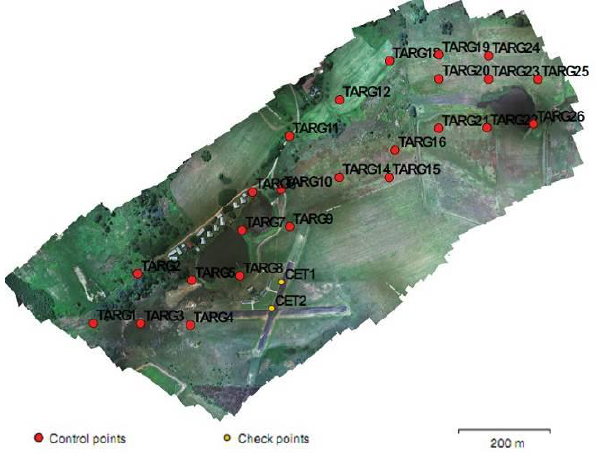
Figure 2.The placement of ground control markers and checkpoints over the study area.